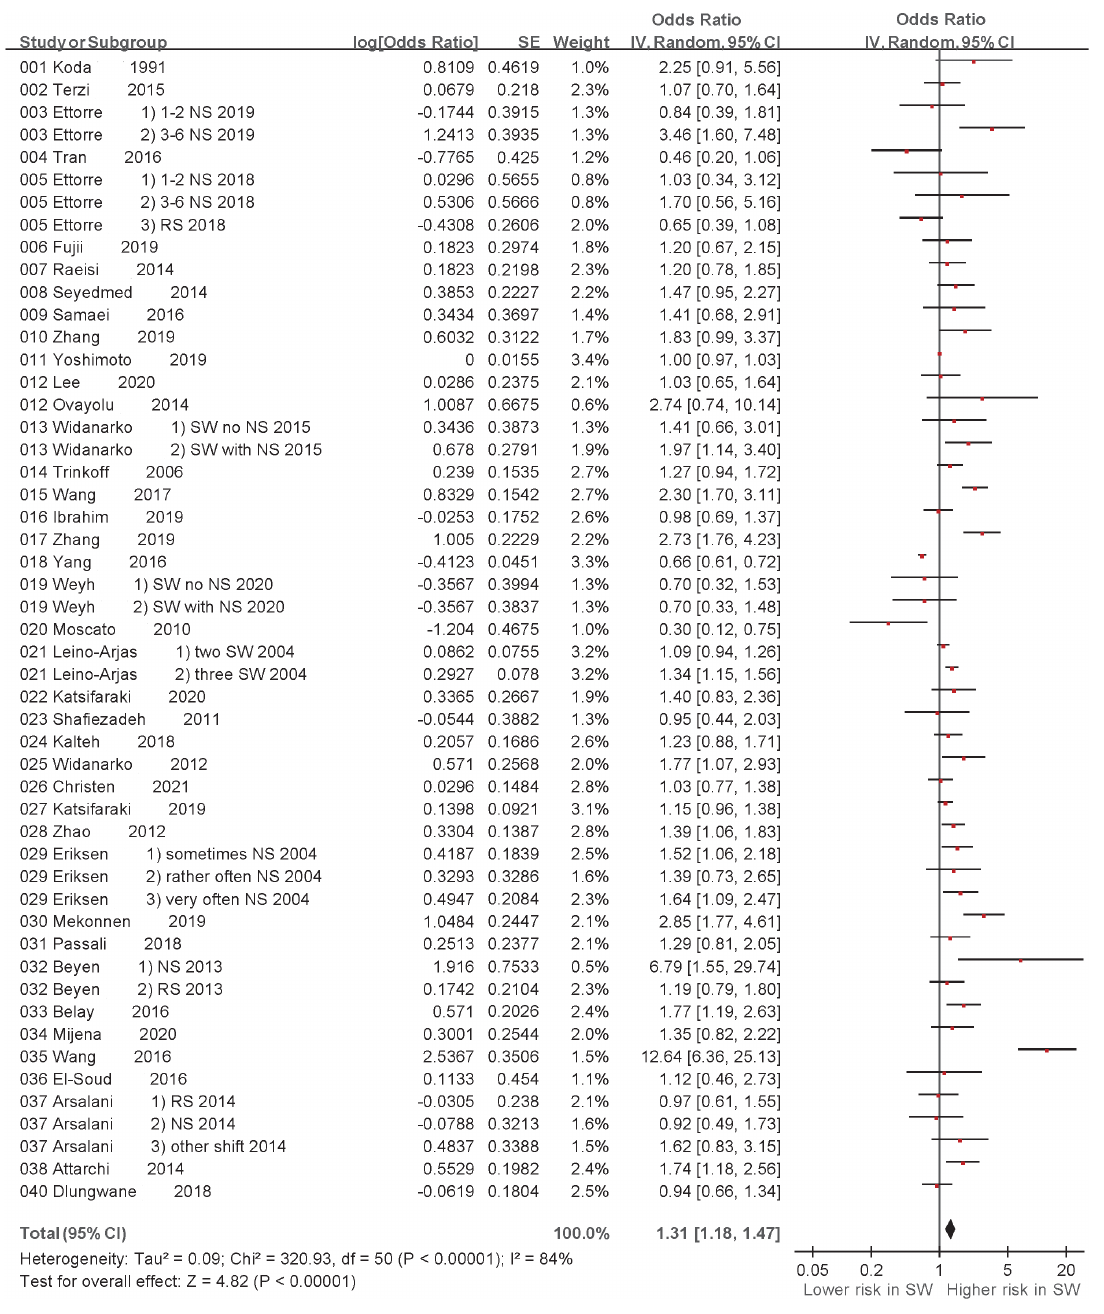
Figure 2. Figure 2. Shift work and odds ratio of low back pain in the 40 studies: a random-effects model (CI, confidence interval; SE, standard error)